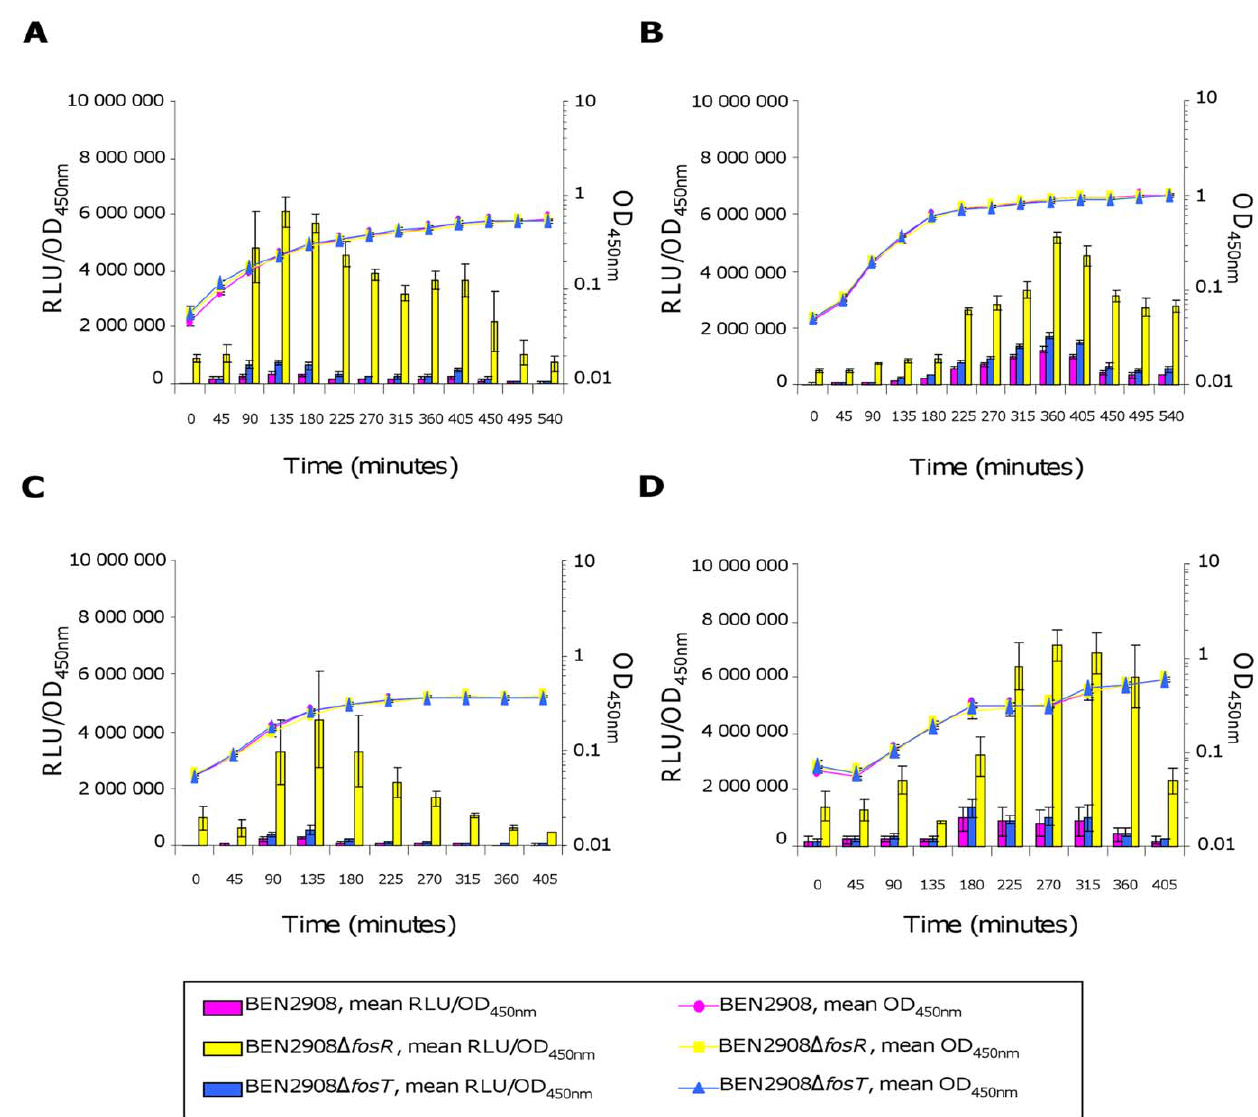
Figure 2. fos operon promoter activity in extracts of target organs of avian colibacillosis. Growth curves (OD 450 nm ) and relative luminescence intensities (RLU/OD 450 nm ) of strains BEN2908, BEN2908 D fosR and BEN2908 D fosT carrying pQF52 grown without shaking at 37 u C in M9 minimal medium supplemented with (A) 10% of lung extract, (B) 4% of liver extract, (C) 4% of spleen extract, (D) 4% of pericardial fluid. The RLU average values and standard deviations result from three independent